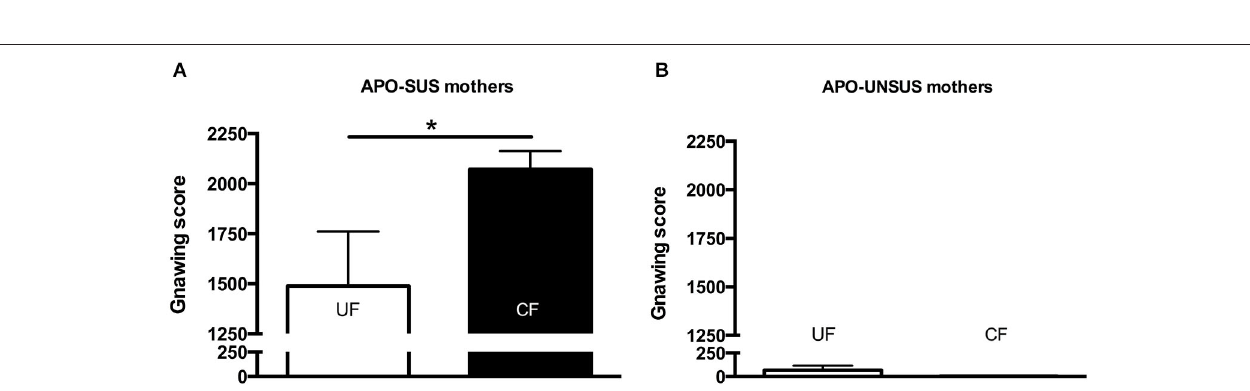
FIGURE 4 | Novelty-induced locomotion in male APO-SUS (A) and APO-UNSUS (B) pups as well as female APO-SUS (C) and APO-UNSUS (D) pups after being unfostered (UF; white bars) or cross-fostered (CF; black bars). * p < 0.05.